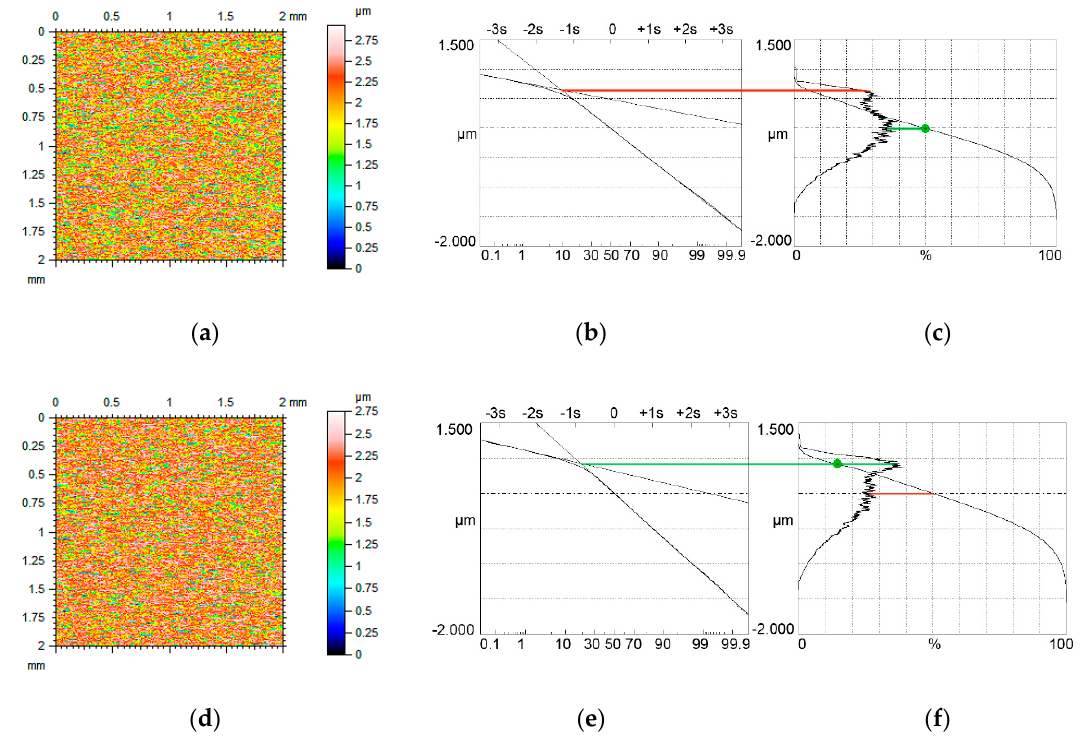
Figure 4. Contour plots ( a , d ) surface probability plot ( b , e ), material ratio curve and probability distribution ( c , f ) of two-process isotropic modeled surfaces of the Smq parameter of 10% ( a – c ) and 20% ( d – f ), the other parameters of both surfaces are Spq = 0.12 µm, Svq = 0.5 µm, both surfaces have bimodal ordinate distribution.